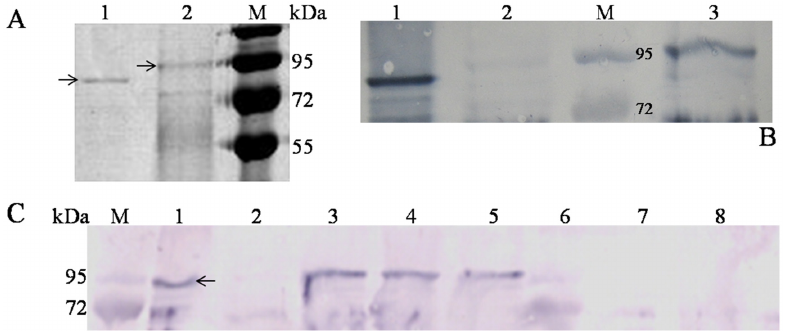
Fig 4. SDS-PAGE and western blot analysis of gene expression in P . pastoris and transgenic maize. (A) SDS-PAGE analysis of recombinant Aga-F75 produced in P . pastoris . Lanes: 1, the purified Aga-F75 with PNGase F treatment; 2, the purified Aga-F75; M, the protein molecular markers. (B) Western blot analysis of Aga-F75M produced in transgenic maize. Lanes: 1, the protein extract of transgenic maize seeds with PNGase F treatment; 2, the protein extract of non-transgenic Zheng58 seeds as a negative control; M, the protein molecular markers; 3, the protein extract of transgenic maize seeds. (C) Specific expression of Aga- F75M in transgenic maize. Lanes: M, the protein molecular markers; 1, the purified recombinant Aga-F75 produced in P . pastoris ; 2, the protein extract of non-transgenic Zheng58 seeds; 3 – 5, the protein extracts of transgenic maize seeds; 6 – 8, the protein extracts of leaf, stem, and root of the transgenic plant,